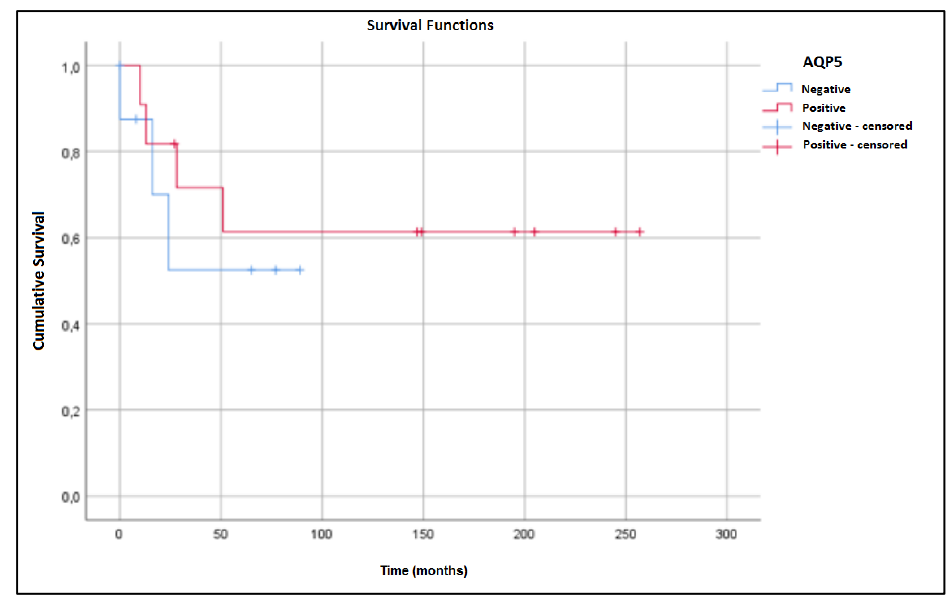
Figure 5. Overall survival curves of MEC patients. Five-year survival rates were 52.5% for patients without AQP5 expression and 61.4% for patients with expression ( p = 0.574).